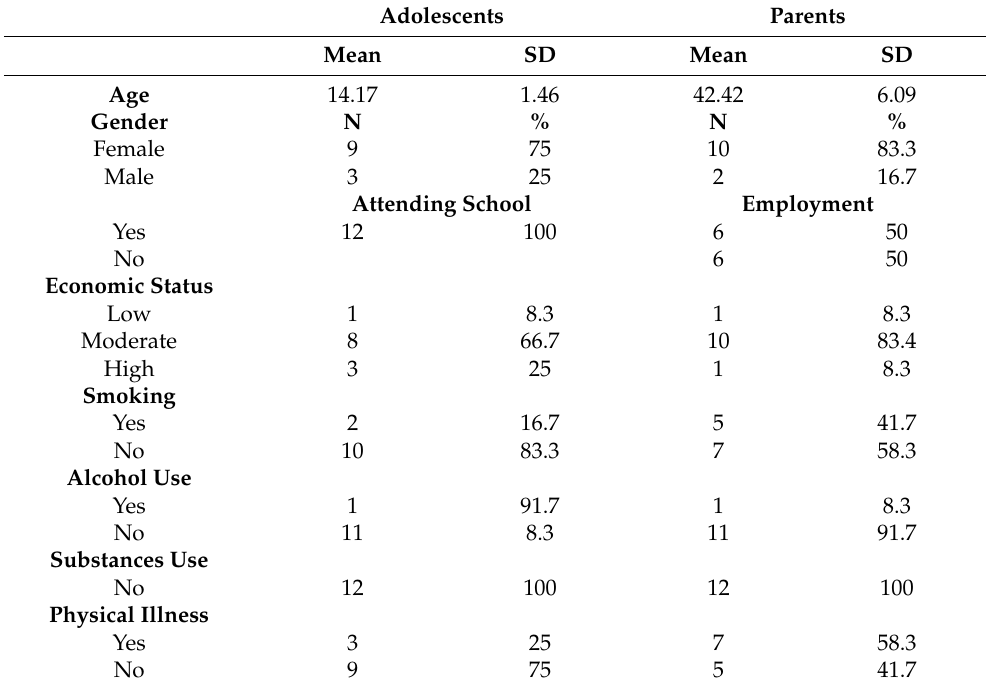
Table 1. Characteristics of the